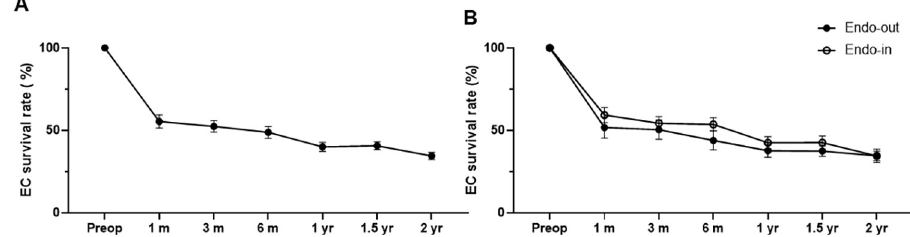
Fig 5. Cumulative endothelial cell survival rate of Descemet membrane endothelial keratoplasty (DMEK) using overseas transport pre-cut tissues within 3-day pre-cut-to-use period. Cumulative endothelial cell (EC) survival rate in total cases (A). Comparison of the cumulative EC survival rate after DMEK between endothelium-out (endo-out) and endothelium-in (endo-in) groups (B). Total 17 eyes (endo-out; n = 9 vs endo-in: n = 8) were included in 1.5-year FU and 14 eyes (endo-out; n = 9 vs endo-in: n = 5) were included in 2-year FU. There were no differences between those two groups over time. Data are expressed as the mean ± standard error of the mean (A, B). https://doi.org/10.1371/journal.pone.0270037.g005 Comparative efficacies of DMEK outcome between the endothelium-out and endothelium-in deliveries The overall survival rate was 66.7% in the endothelium-out group and 86.7% in the endothe- lium-in group (Fig 6A). The mean survival times were 32.2 ± 19.7 and 21.0 ± 7.9 months in the endothelium-out and endothelium-in groups, respectively, without a significant difference (p = 0.219, Fig 6A). The EC survival rate, ECD and CCT in the endothelium-in group at each time point were comparable to those in the endothelium-out group (p > 0.05, Figs 5B, 6B and 6D). The postoperative BCVA was 0.28 ± 0.4 in the endothelium-out group and 0.28 ± 0.3 in the endothelium-in group (p = 0.987, Fig 6C). The percentage of eyes with a BCVA better than 20/ 40 was 78.6% in the endothelium-out group and 71.4% in the endothelium-in group (p > 0.05).